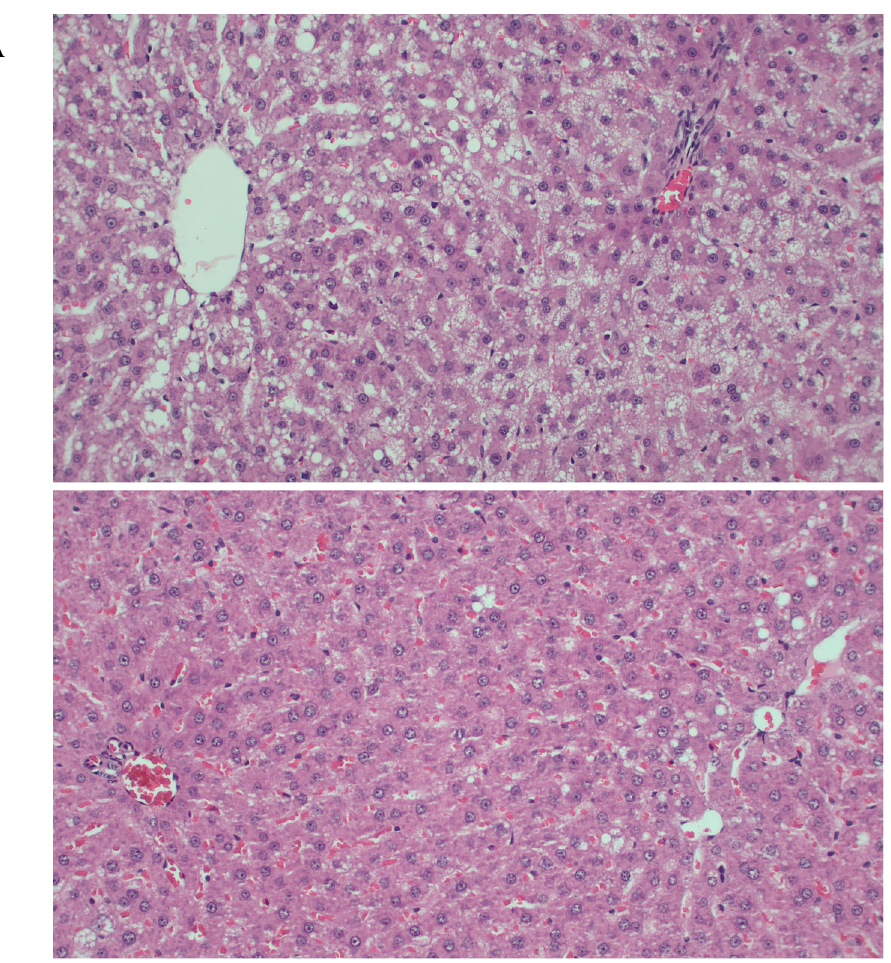
Figure 3. Representative histological liver sections (magnification 20×): ( A ) A sample from the control group with marked fatty change showing mixed small- and large-droplet macrovesicular steatosis; ( B ) A sample from the nutraceuticals group showing mild large-droplet macrovesicular steatosis.